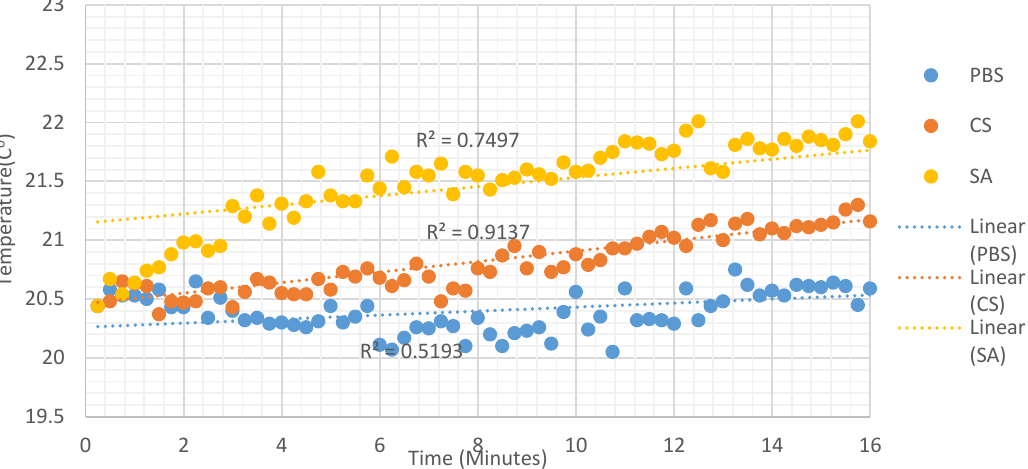
Figure 5. Temperature variations over 15 min of di ff erent AuNPs from the time the PA was turned on.